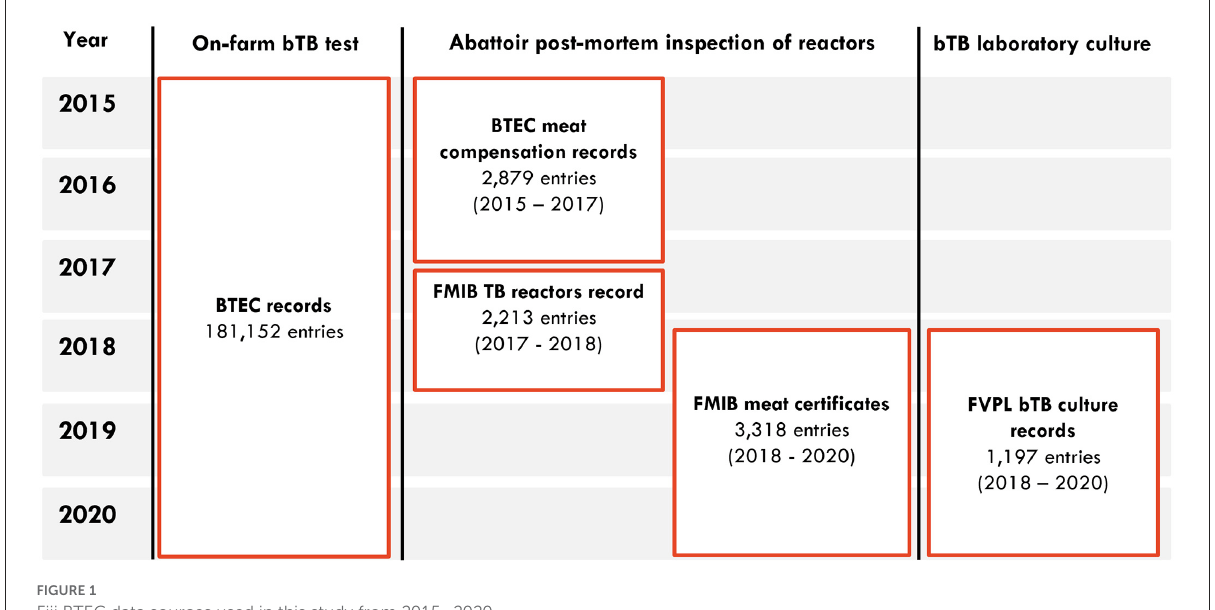
FIGURE1 Fiji BTEC data sources used in this study from